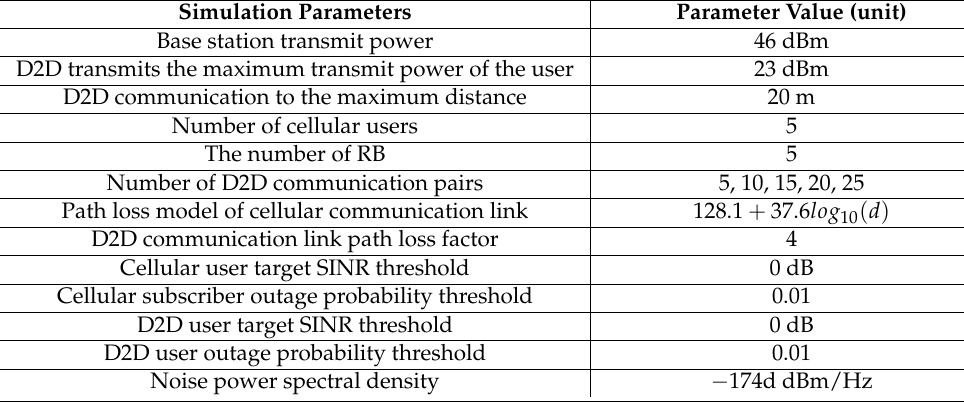
Table 1. Simulation